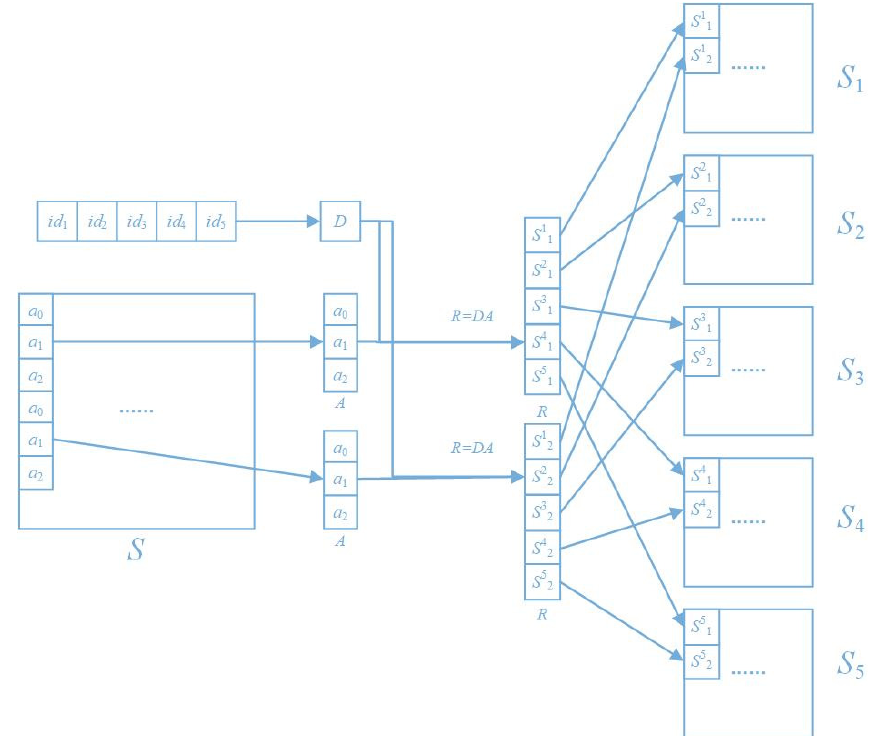
Figure 1. The schematic diagram of the sharing process.